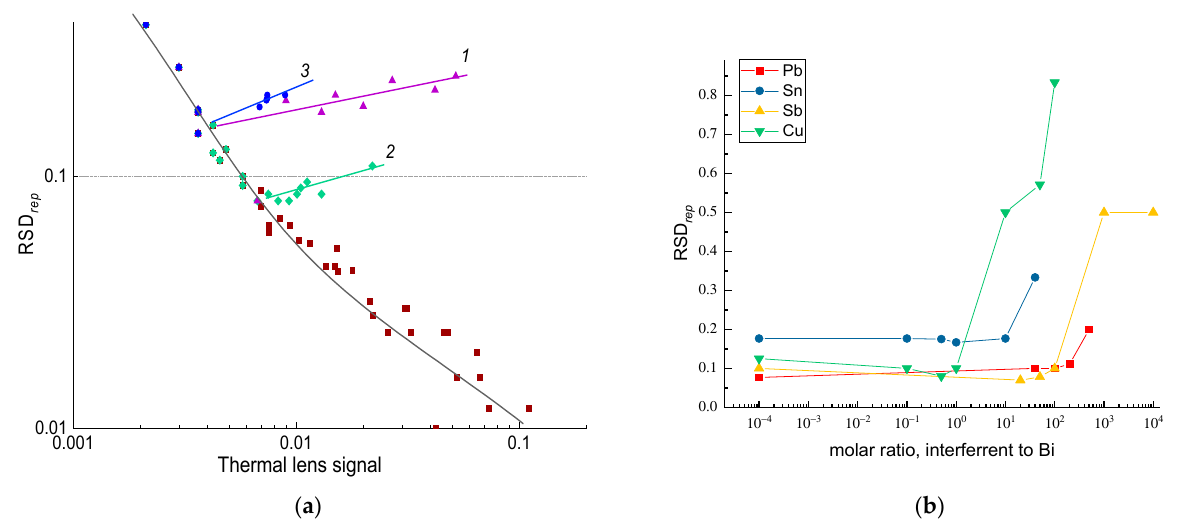
Figure 15. Dependence of repeatability relative standard deviation (RSD rep ) of thermal-lens measurements ( a ) in surfactant-containing aqueous solutions on the thermal-lens signal for MetHbCN solution (red) and Triton X-100 ( 1 ), Brij-35 ( 2 ), and SDS ( 3 ) (ammonium dichromate is used as an inert colorant to increase the absorbance), where the theoretical curve for water (black line) is calculated from Equation (21), and ( b ) in bismuth solutions in the presence of iodide ions and various amounts of interfering elements on their molar ratio. Setup, TLS-60; excitation wavelength, 514.5 nm; excitation power, 40.0 mW.